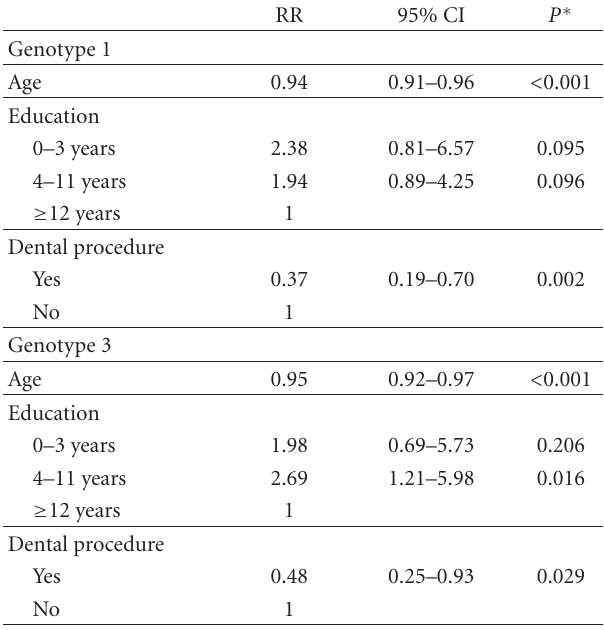
Table 3: Risk factors for genotype 1 and for genotype 3 compared to genotype 2 in patients with HCV infection in the countryside of southern Brazil.